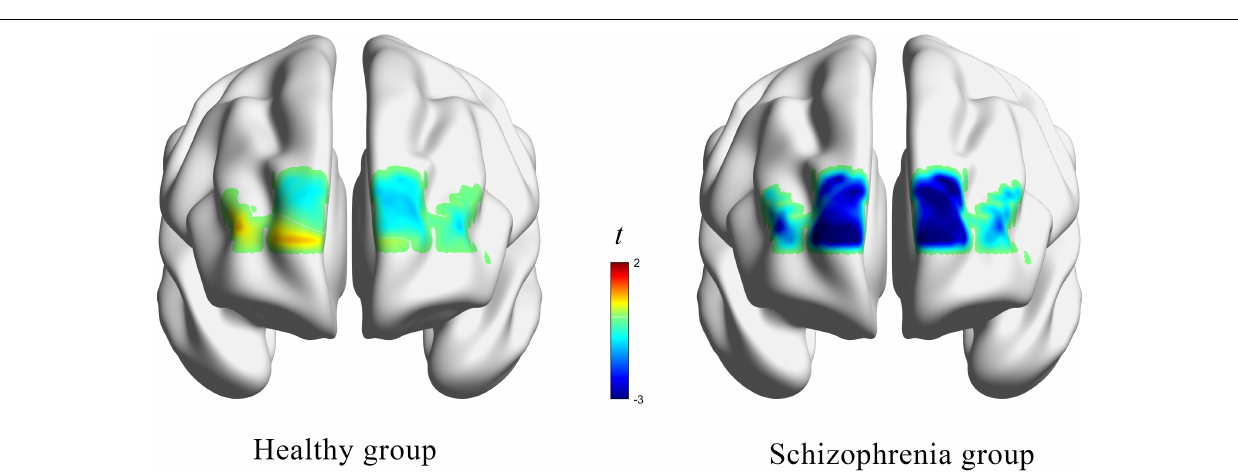
FIGURE 4 | The t value (compared to 0) of brain activation in participants during emotion expression through